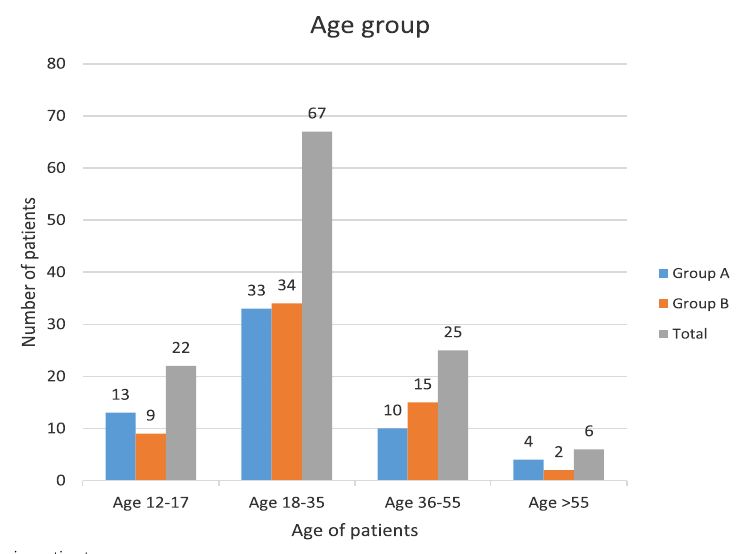
Fig. 1 Different age groups in